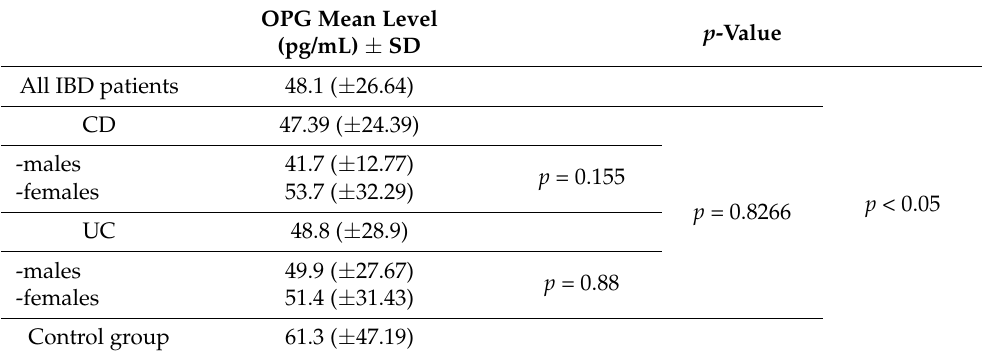
Table 3. Serum OPG levels across each group.